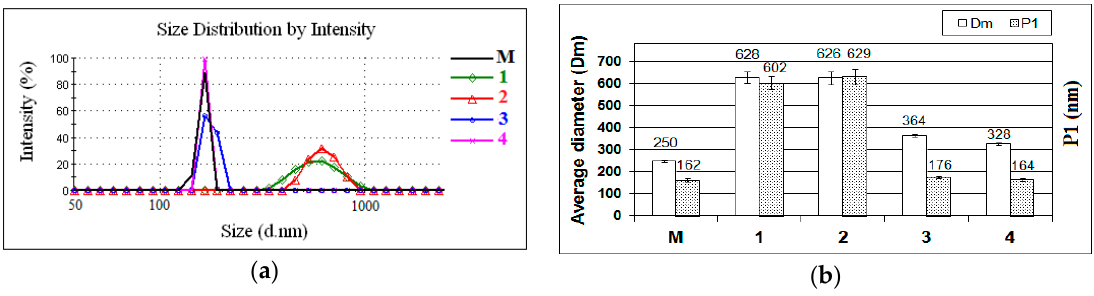
Figure 2. ( a ) Particle size distributions and ( b ) average diameters (Dm) and main peak (P1), obtained for unfunctionalized ZnO (M) and for ZnO nanoparticles modified with (1) GPTMS, (2) PhTES, (3) OTES, and (4) ODTES, respectively.